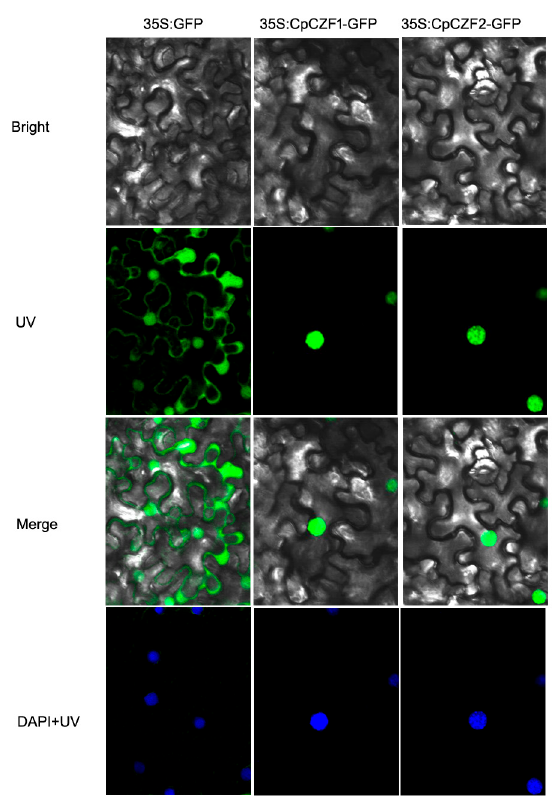
Figure 3. Subcellular localizations of CpCZF1 and CpCZF2 Tobacco leaf epidermis were transformed with 35S-GFP , 35S:CpCZF1-GFP , and 35S:CpCZF2-GFP constructs by an Agrobacterium mediated